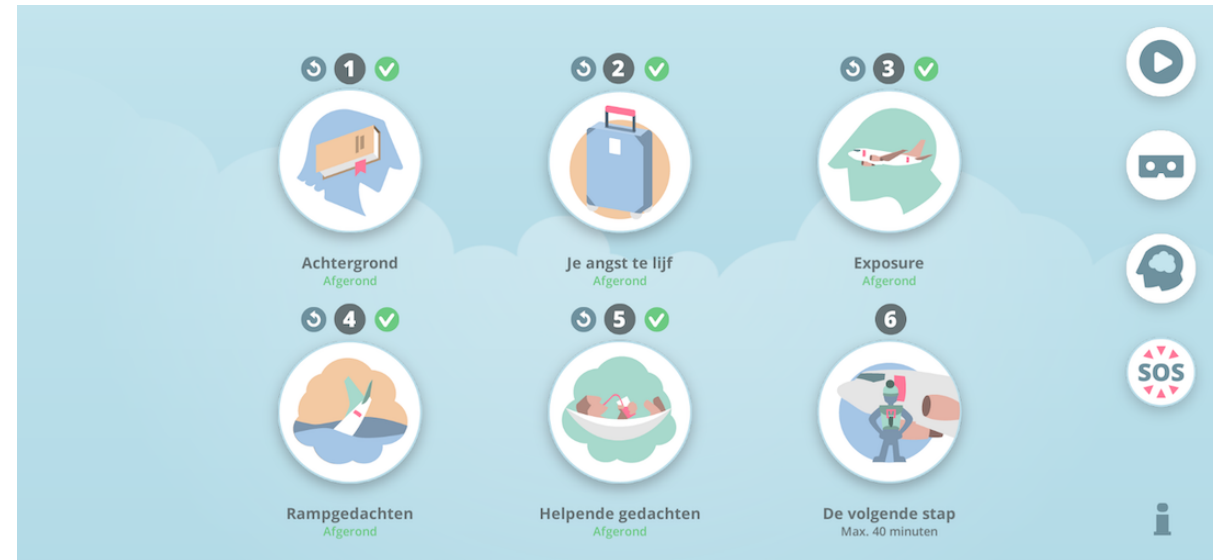
Figure 3. The home screen of ZeroPhobia. For translations of module names, see Table